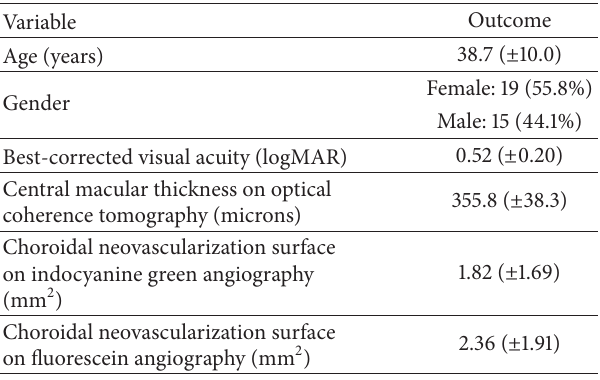
Table 1: The baseline means and distributions of the study popula-